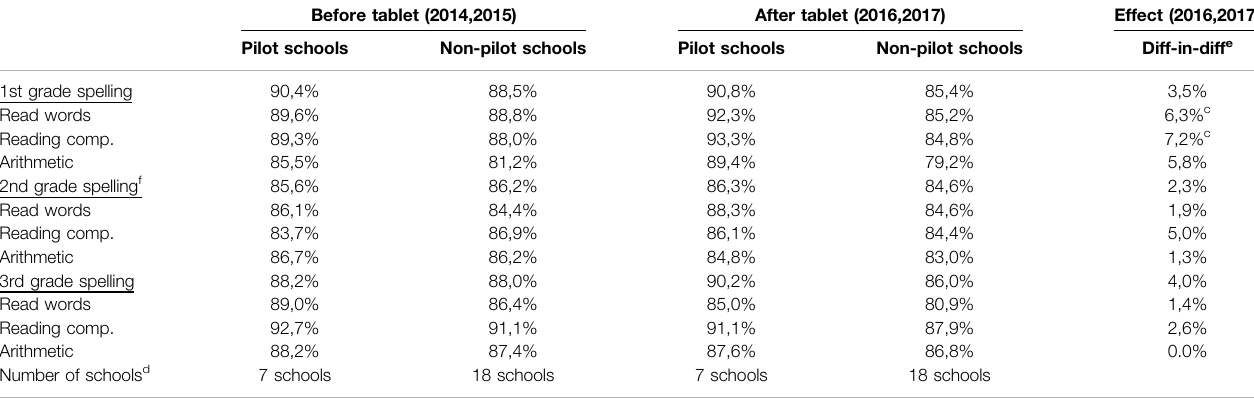
TABLE 10 | Difference-in-difference analysis of share of students above critical limit, fi rst, second, and third grades (group 2).